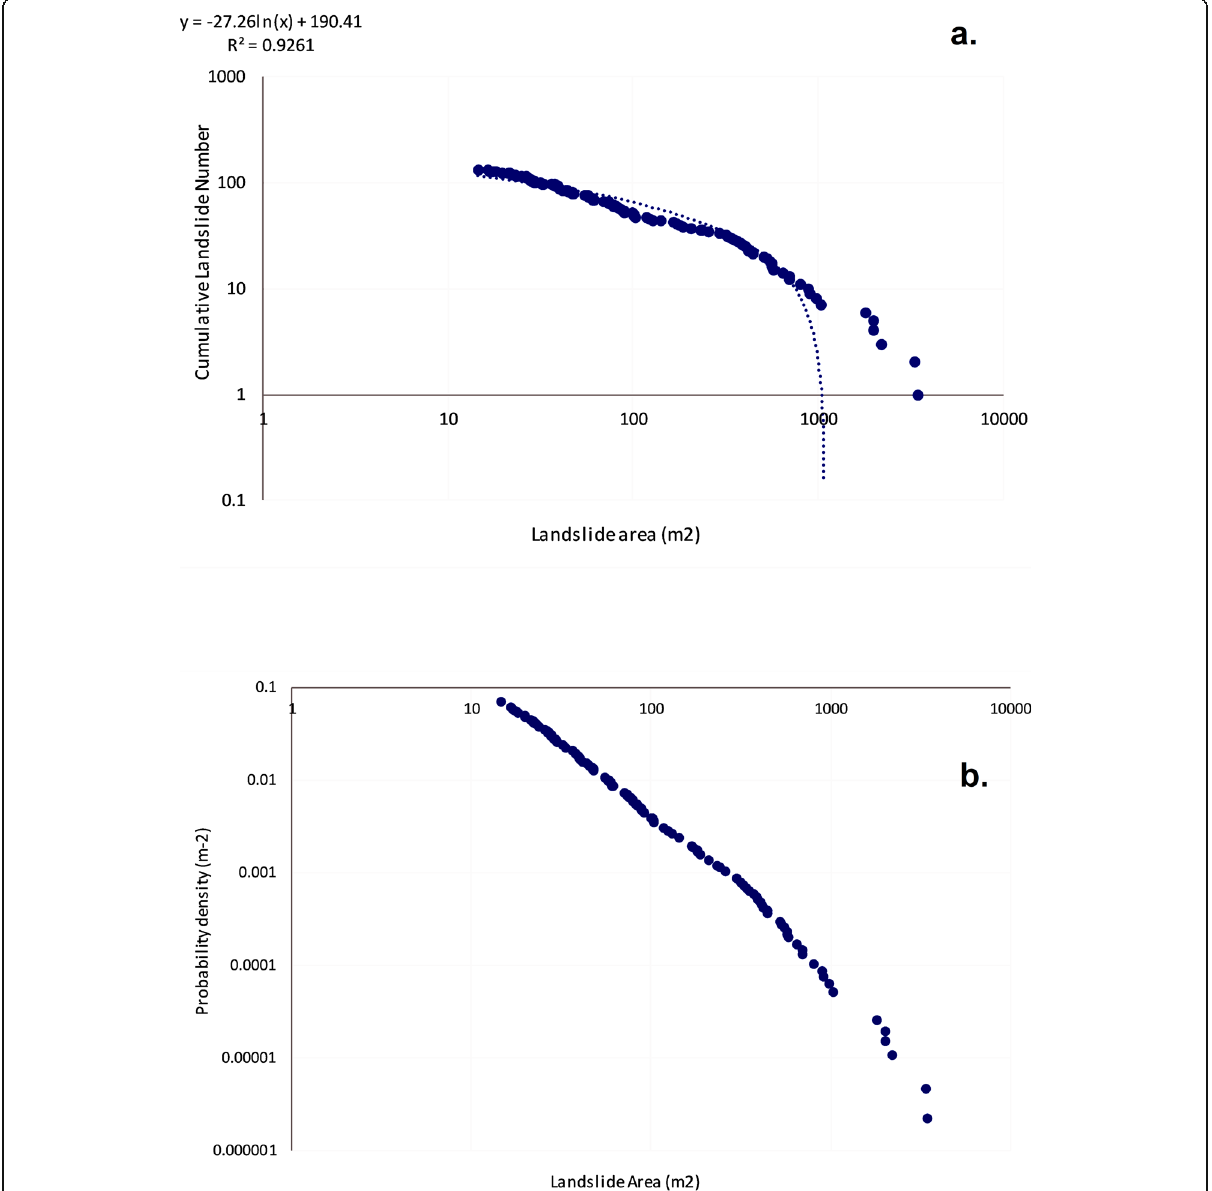
Fig. 6 Size Distribution of Landslides in Logarithmic Forms: a . Cumulative Landslide Number and Size Distribution b . Probability Density and Size